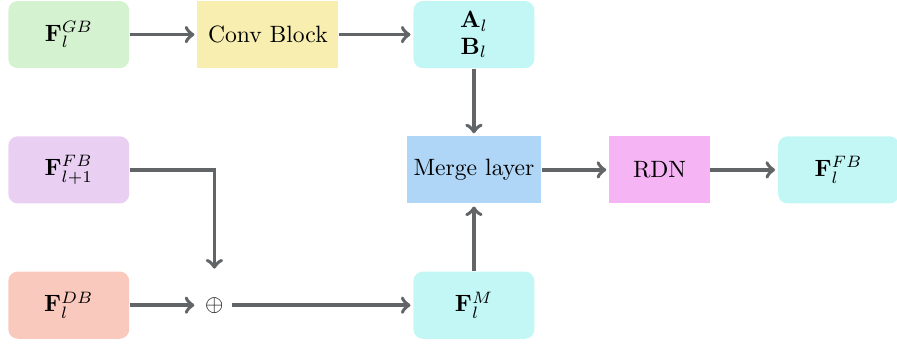
Figure 4. The architecture of the Fusion Block. Note that two